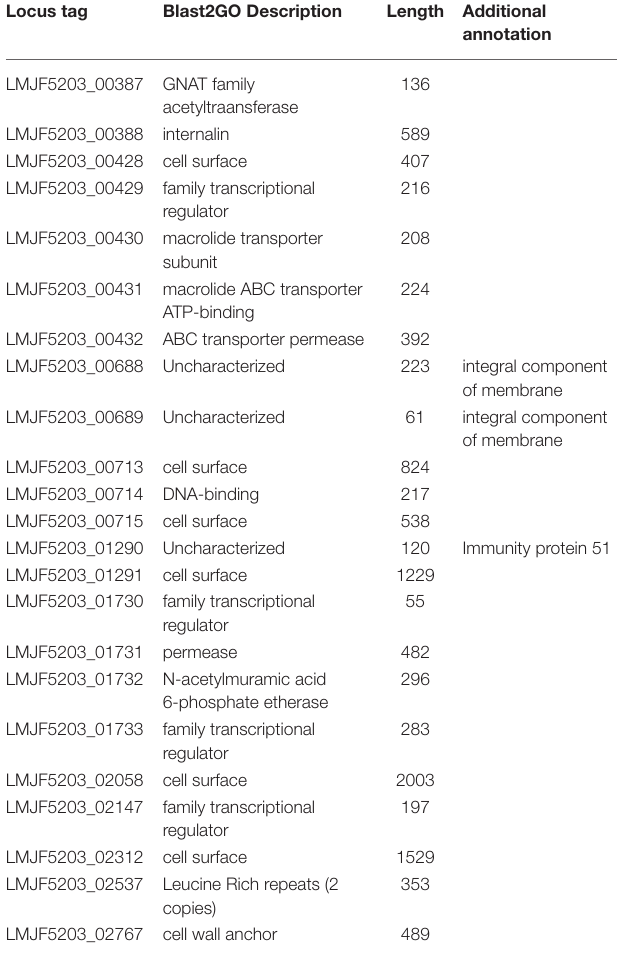
TABLE 2 | Genes specific to lineage I selected after the RPKM comparison between the two lineages. Locus